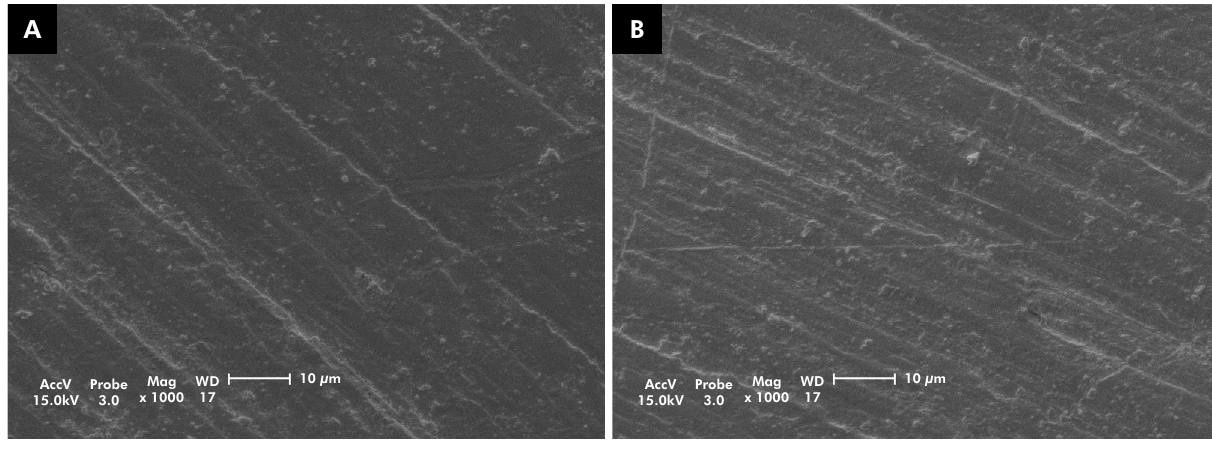
Figure 2. SEM images of acrylic resin block surfaces at 1000× magnification: (a) non-coated specimen; (b) silicon dioxide- coated